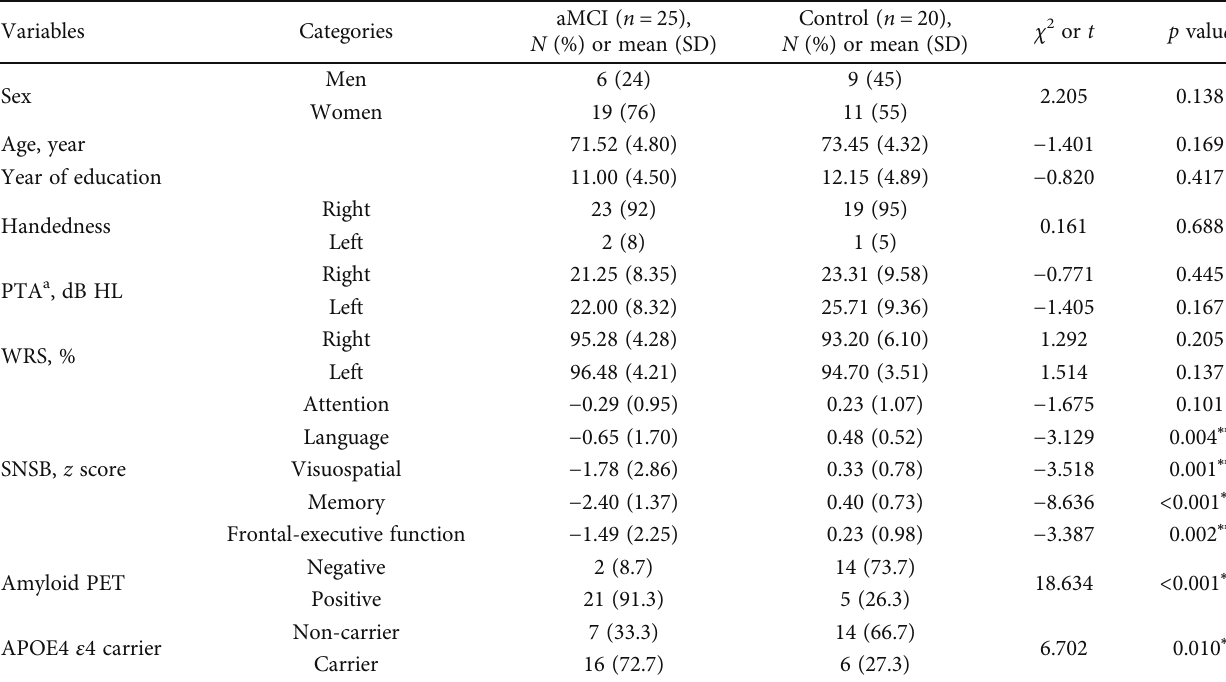
Table 1: Characteristics of